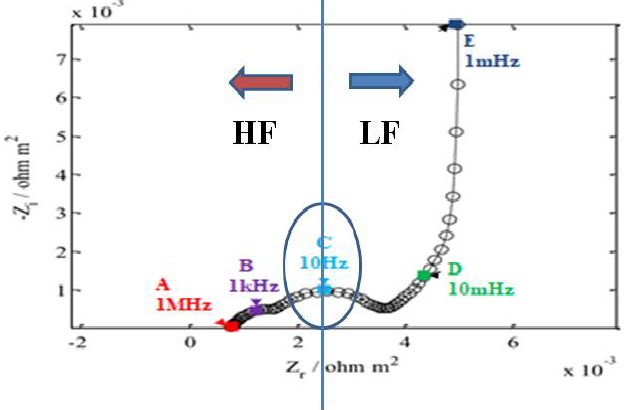
Figure 13. Cole–Cole plot impedance characteristics through the frequency spectroscopy. Table 4. Frequency of regions. Low Freq. High Freq.